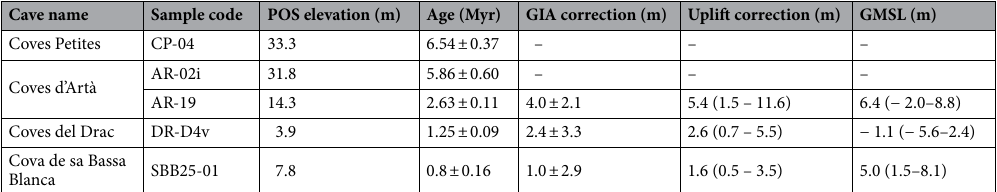
Table 1. POS data and inferred GMSL estimates. Measured elevations have an uncertainty of 0.25 m. Age uncertainties are reported as 2σ absolute values. The GIA correction uncertainty is 1σ. Uplift correction shows the median value and the 16th and 84th percentiles in parentheses as uncertainty bounds. The GMSL estimates include correction for GIA and long-term uplift and show the mode and the 16th and 84th percentiles in parentheses as uncertainty